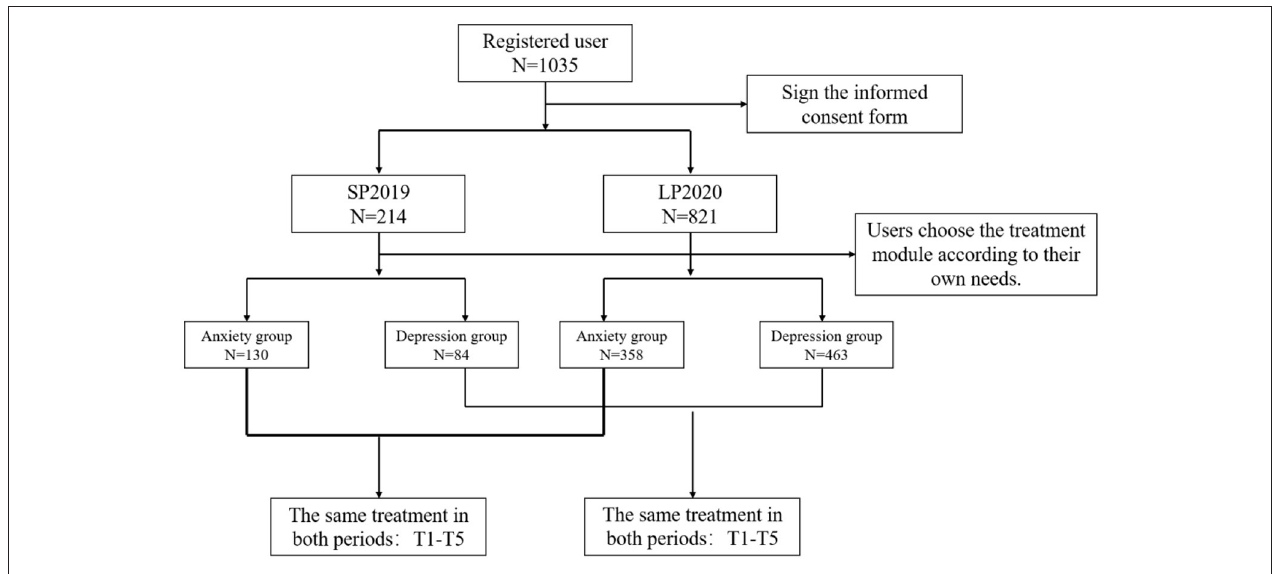
FIGURE 1 | Diagram of participant